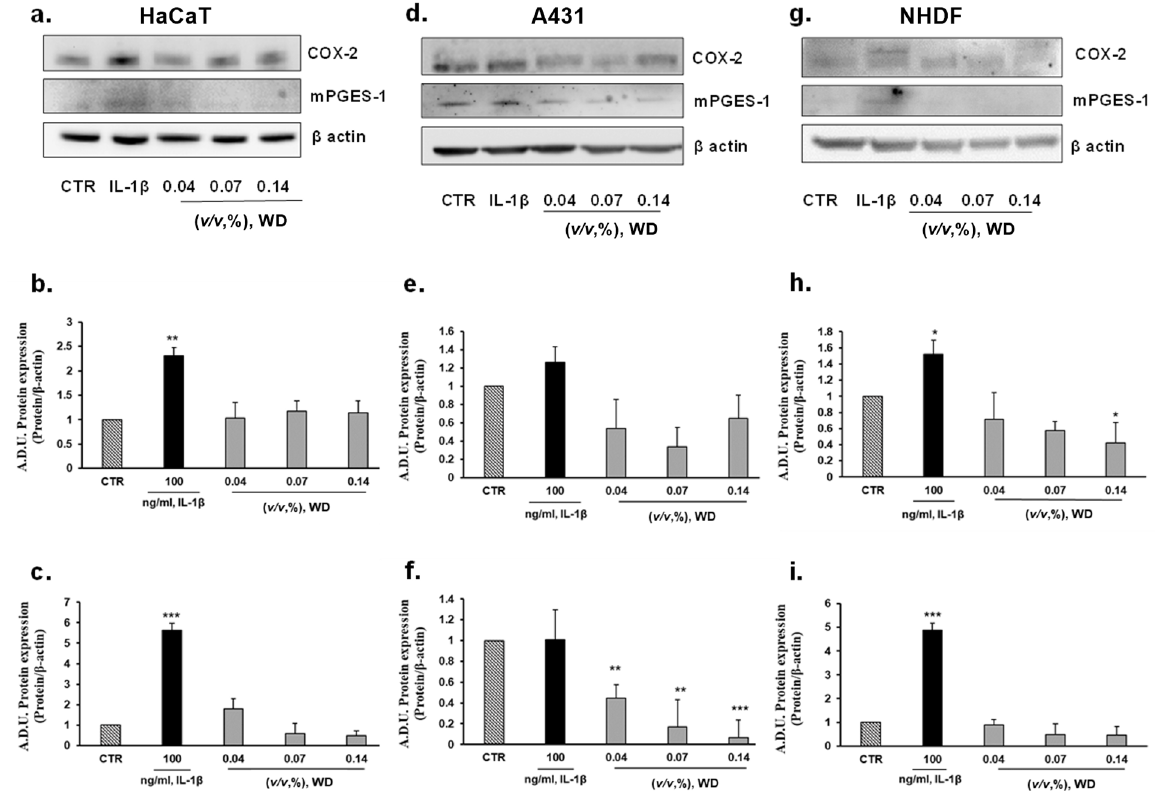
Figure 4. Effect of WD on the expression of inflammatory markers COX-2 and mPGES-1. Keratinocytes HaCaT ( a – c ), model of mucosal epithelial cells ( d – f ) and fibroblasts NHDF ( g – i ) were treated with increasing doses of WD, 0.04–0.14%, for 1 h and after incubated for 24 h with fresh medium added with 1%FBS. Results were compared with untreated cells and cells under a fixed dose of interleukin-1β (IL-1β, 100 ng/mL), for 1 h. The treatments were performed under experimental condition of medium with 1% FBS. Signals were evaluated through Western blot and normalized on β-actin expression. Data were reported as arbitrary densitometry units (A.D.U.) ± SD of each signal/β-actin vs. basal control. (n = 3). * p < 0.05, ** p < 0.01, *** p < 0.001 vs. untreated cells (CTR).